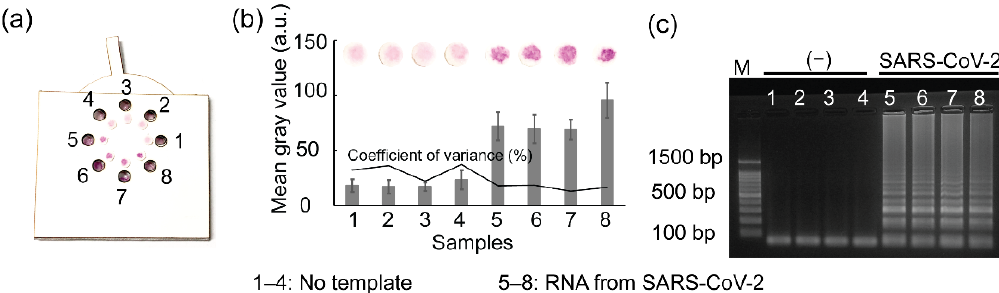
Figure 7. Results showing ( a ) SARS-CoV-2 detection using the rotatable paper device, ( b ) mean gray analysis, and ( c ) agarose gel electrophoresis. Lane M shows 100 bp ladder. Lanes 1–4 show RT-LAMP performance without RNA template. Lanes 5–8 show RNA amplification from SARS-CoV-2.